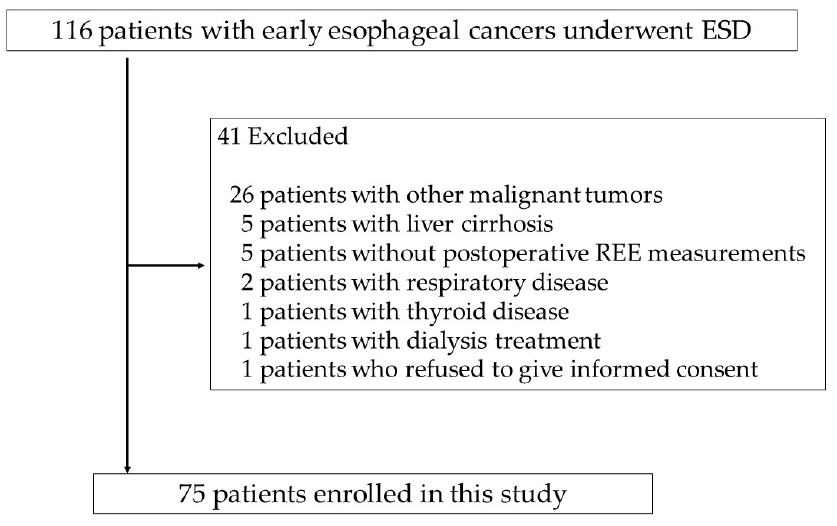
Figure 1. Flow chart of study patient selection. Table 1. Patient baseline characteristics.